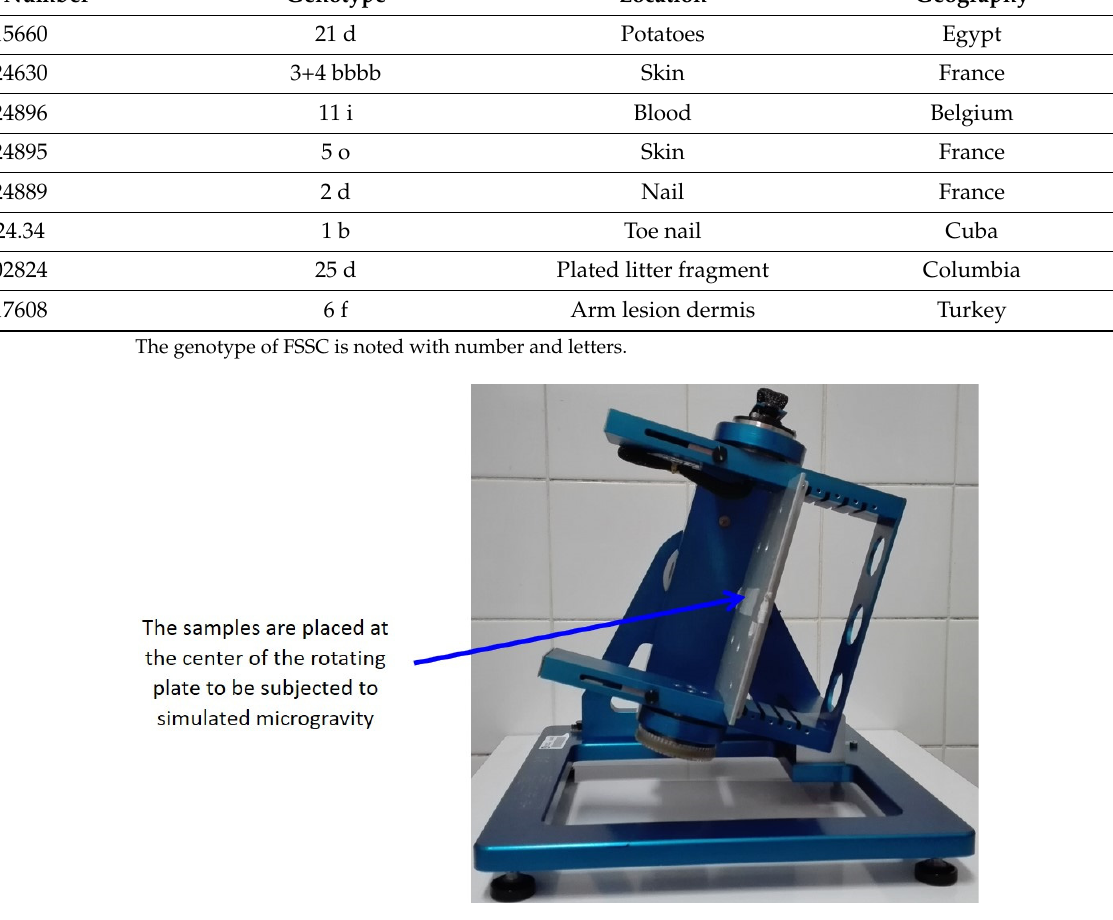
Figure 1. Photograph of the random positioning machine (personal collection). This equipment allows the exposure of biological samples to simulated microgravity. This machine rotates the sample randomly around the Earth’s gravity vector resulting in an average net force close to zero, thus simulating microgravity.